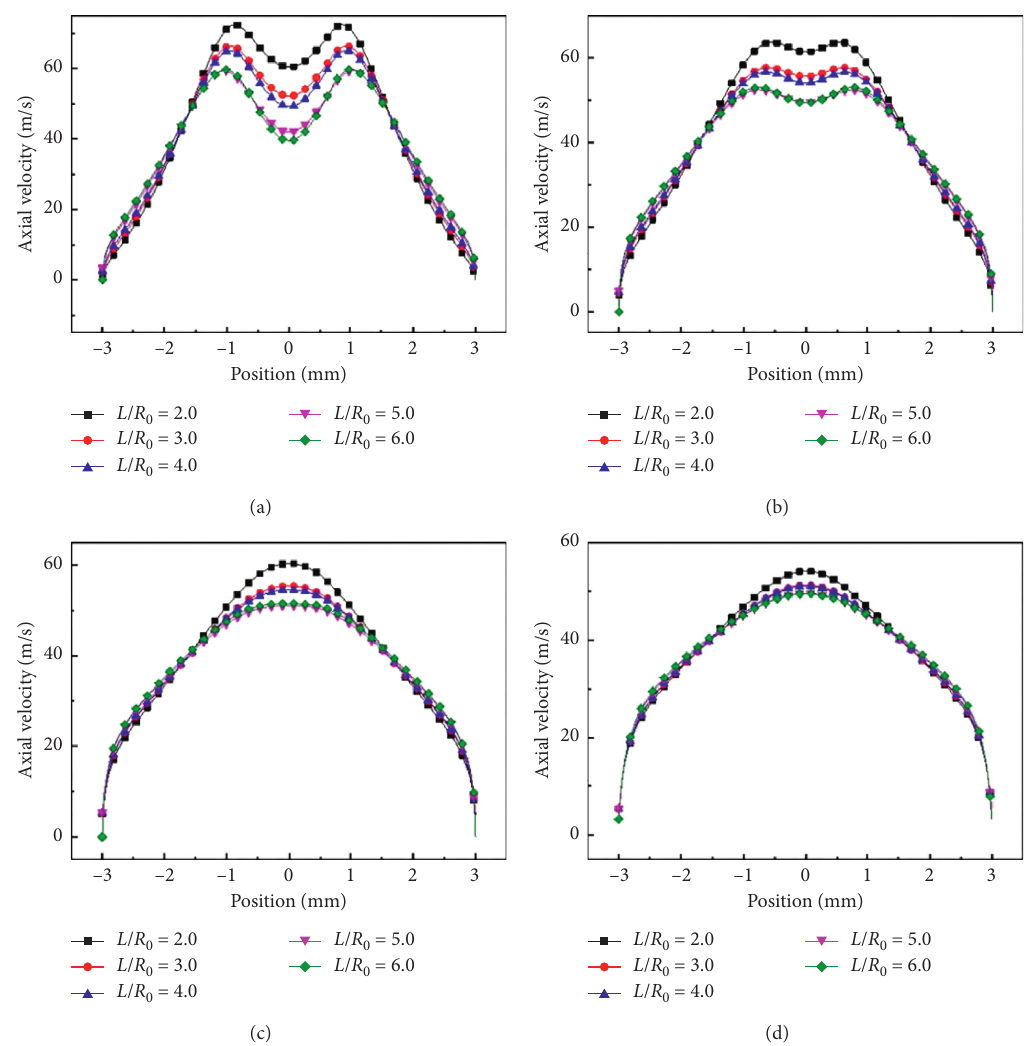
Figure 7: The distribution of the axial velocity downstream in x � 29mm, 32mm, 35mm, and 38mm at the moment of cavitation inception ( T 0 ). (a) x � 29mm. (b) x � 32mm. (c) x � 35mm. (d) x �